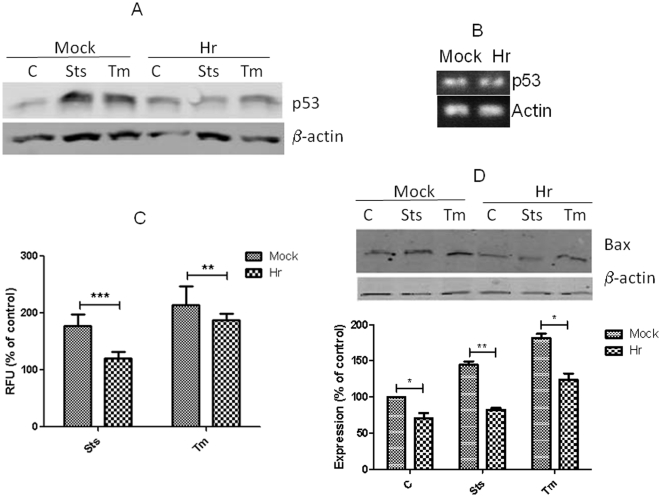
Lower levels of p53 and p53 mediated gene transcription in COS expressing high levels of Hr.At 24 hrs after COS cells were mock transfected or transfected with RK5Hr, cells were treated for 18 hours with staurosporine (sts), tunicamycn (tm), or not treated treated. Levels of p53 protein (A) and mRNA (B) were detected by Western blots and Rt-PCR, respectively. The p53 reporter assays was conducted in cells that were co-transfected with p53 luciferase reporter gene and beta-galactosidase vectors along with the RK5Hr (Hr) or RK5 vectors (mock) (C). Luciferase is expressed in relative fluorescent units (RFU) and was normalized to beta-galacotosidase activity, which was measured colorimetrically. Data are expressed as mean of n = 8 (± S.E.M.). ** and *** indicates significantly difference between knockout and wild-type at p<0.01 and p<0.001, respectively, which was determined with ANOVA and Tukey's post hoc test. Western blot and analysis for Bax was measured in transfected COS cells treated as described above for p53 (D). Data are expressed as mean of n = 3 (± S.E.M.). * and ** indicates significantly difference between knockout and wild-type at p<0.05 and p<0.01, respectively, which was determined with ANOVA and Tukey's post hoc test.